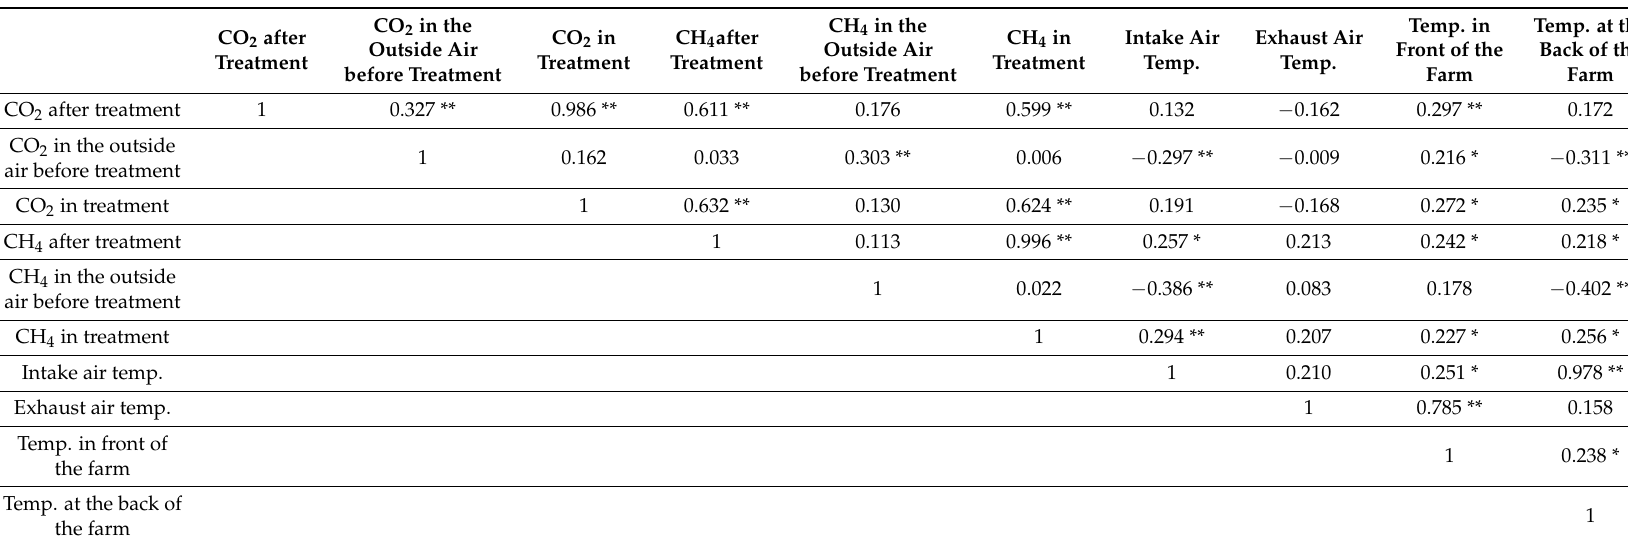
Table 6. Correlation relationship among comparative factors in the soil treatment during the swine manure mixing